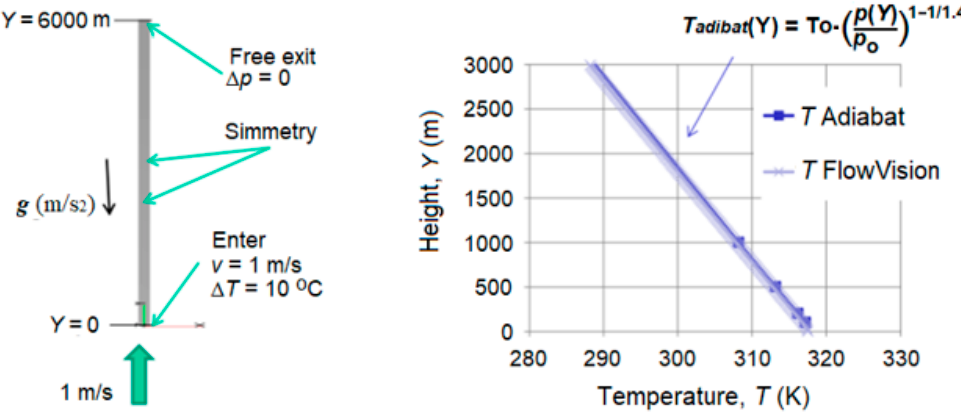
Figure 7. Test comparison of temperature plots for adiabatic rise and in FlowVision.